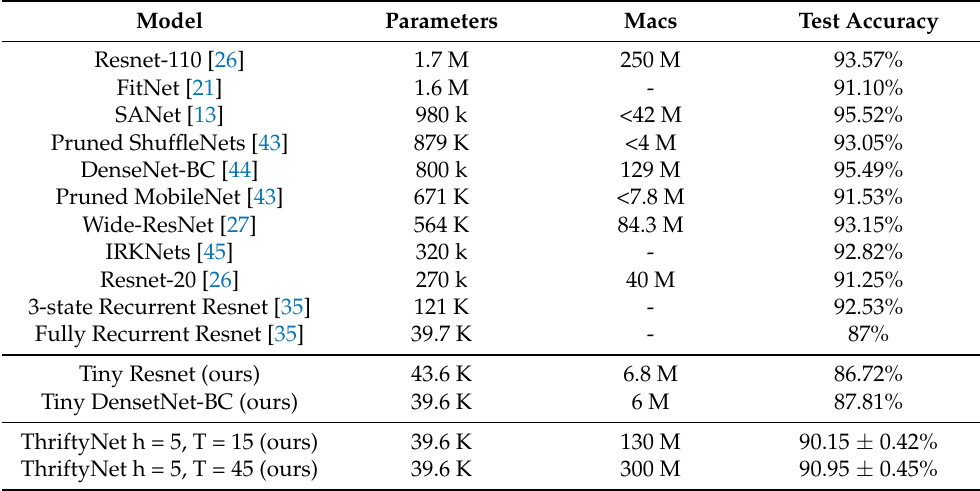
Table 3. Comparative results on CIFAR-10. Experiments were performed 5 times and the interval is the observed standard deviation.